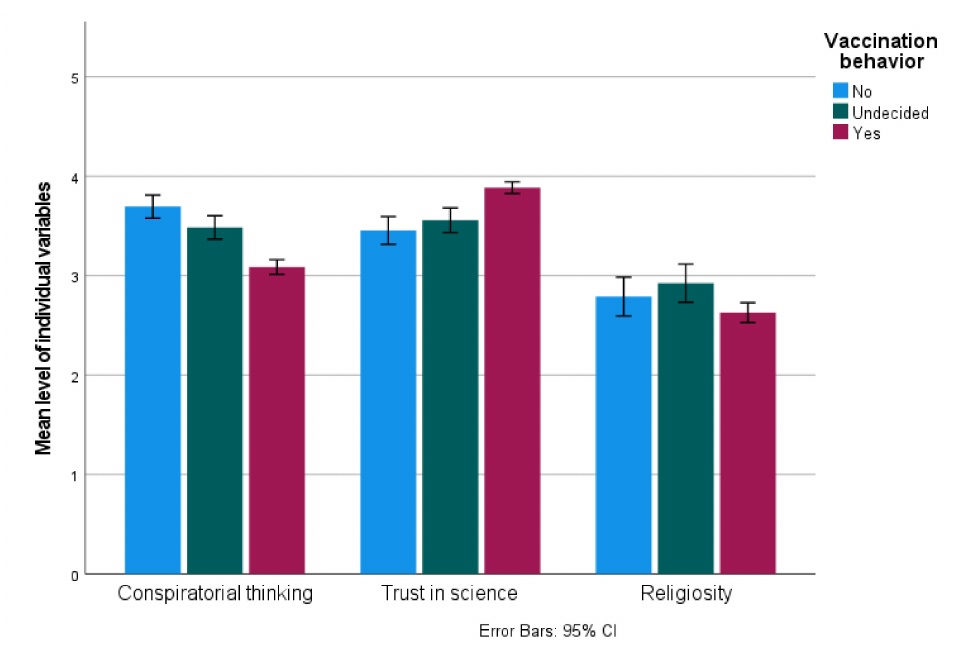
Figure 2. Individual differences and actual vaccination against COVID-19.